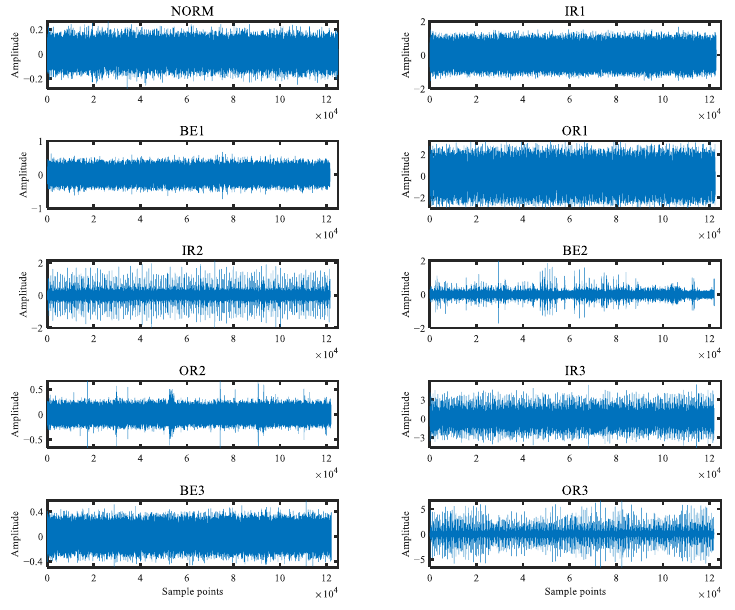
Figure 9. Time domain distribution of ten classes of bearing signals.